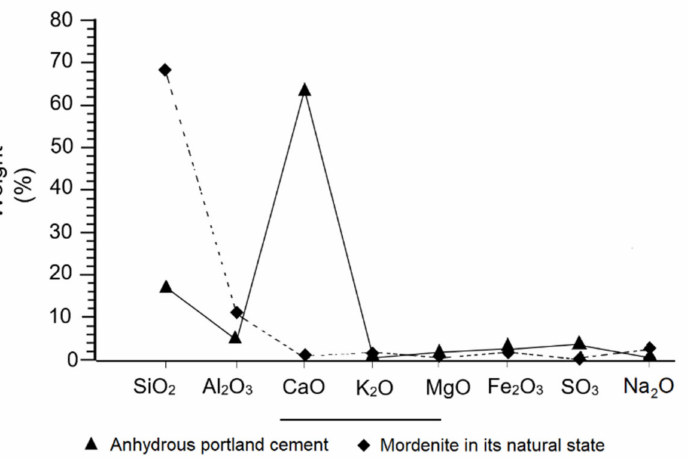
Figure 5. Behaviour of major compounds in the composition of natural mordenite and portland